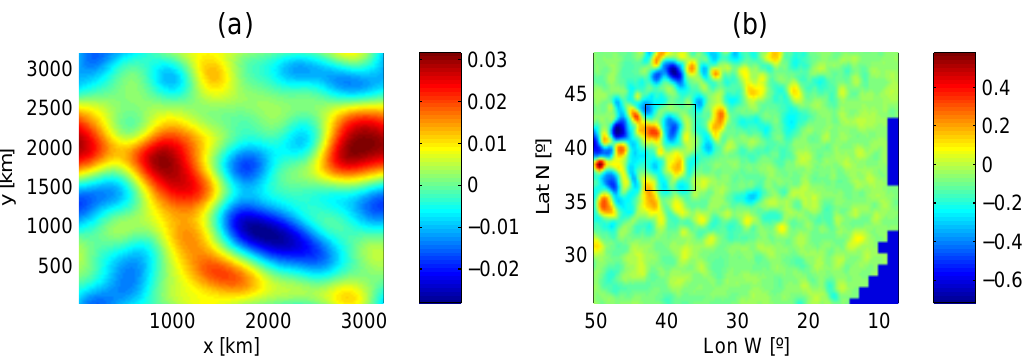
Fig. 1. Stream function for the Gaussian model (a) and the altimetry data (b) . Parameters: (a) τ/T = 1, λ/L = 10, and N x = N y = 128; (b) the area of simulation spans from 25 ◦ N to 49 ◦ N , and from 7 ◦ W to 50 ◦ W ( N x = 130 ,N y = 90). The marked area in the altimetry data is analysed in detail later. The visible land structure is the coast of Spain and